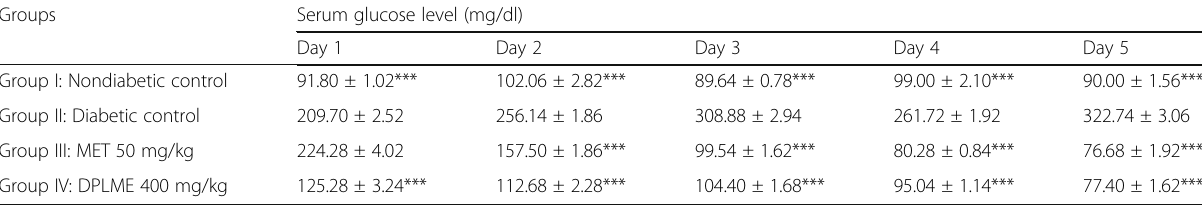
Table 2 Effect of methanolic leaf extract of D. pentandra on Alloxan induced diabetic Rats Groups